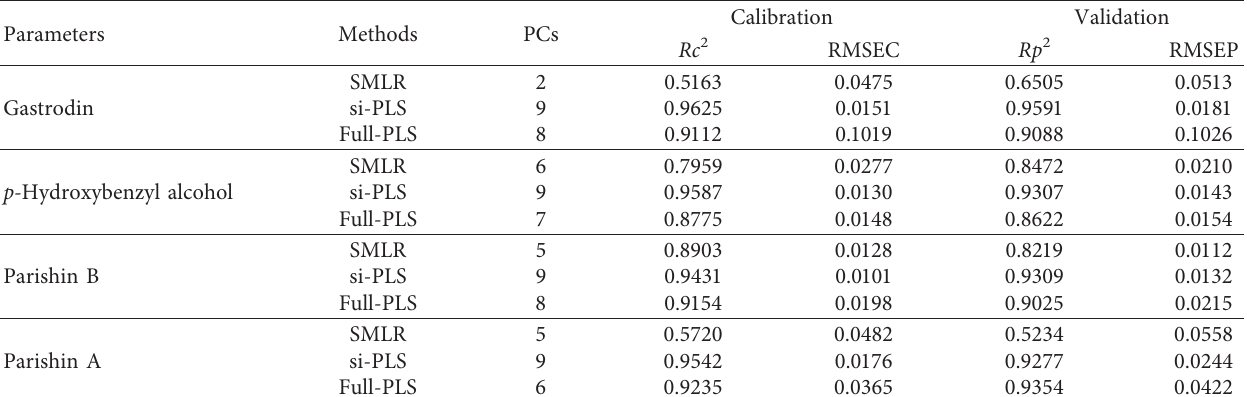
Table 5: Results of different models for predicting gastrodin, p- hydroxybenzyl alcohol, parishin B, and parishin